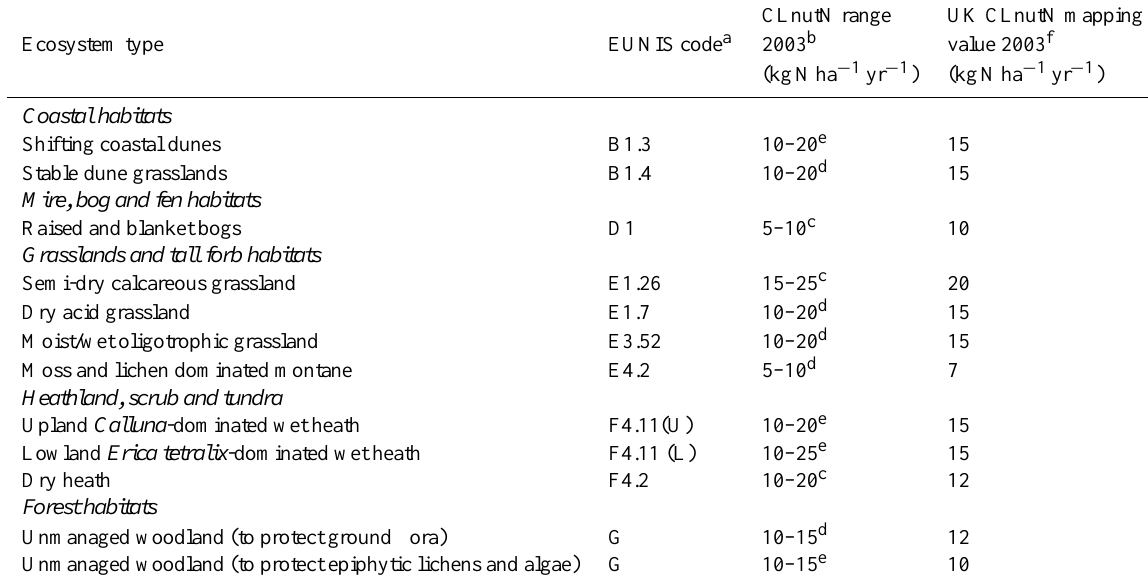
CLnutN range UK CLnutN mapping